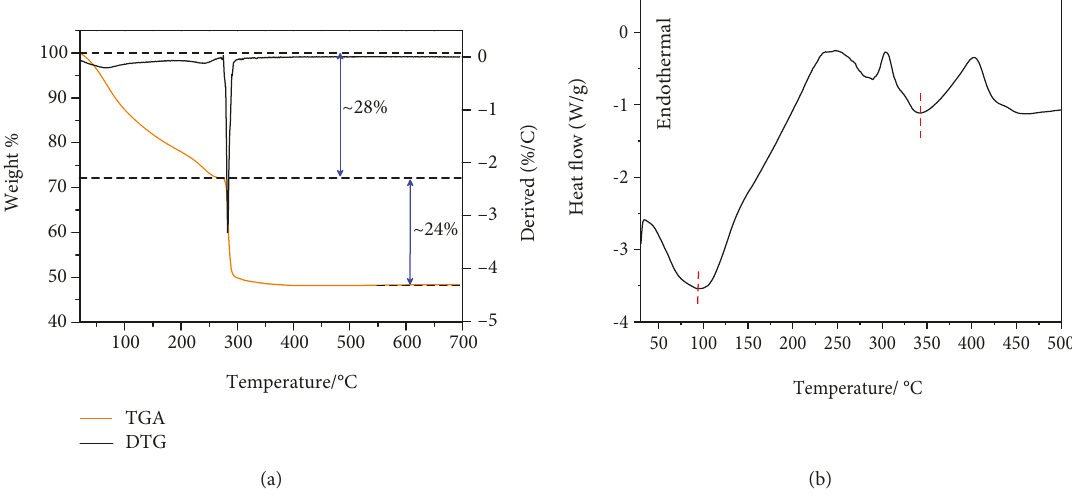
Figure 2: (a) TG/DTG and (b) DSC patterns of Ti(OH)